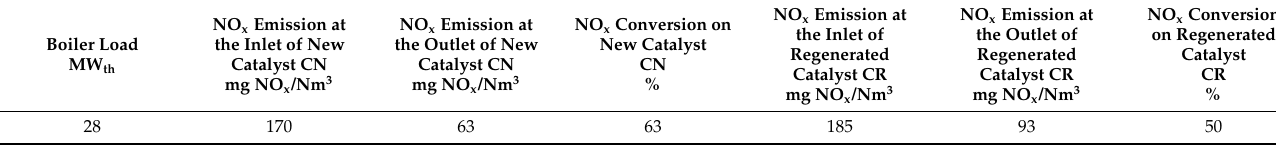
Figure 11. Emissions measured at the inlet and outlet of the regenerated catalyst CR at an average power of 28 MW th -flue gas temperature approx. 400 ◦ C. Table 3. Average NO x emissions and conversion for high boiler